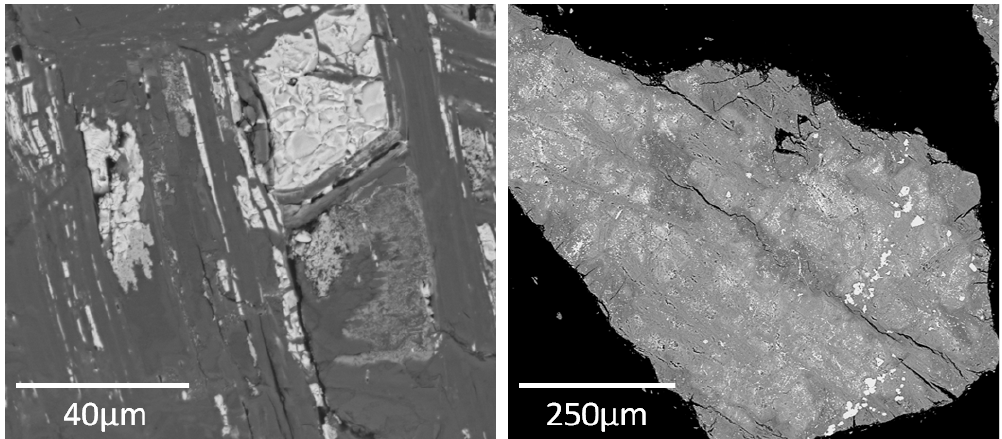
Figure 11. SEM-BSE images of particle cross-sections of crushed, unground (0.425–1 mm) OK ore microwave pretreated for 15 min. The image on the left depicts cracking along mineral grain boundaries, while the image on the right shows cracking in the bulk magnesium silicate [48]. The extent of cracking in untreated and microwave pretreated OK and Pipe ore was quantified, and the results are shown in Figure 12. The degree of cracking increased with increasing microwave length per unit area with each increment of microwave pretreatment. For the Pipe ore, there was a